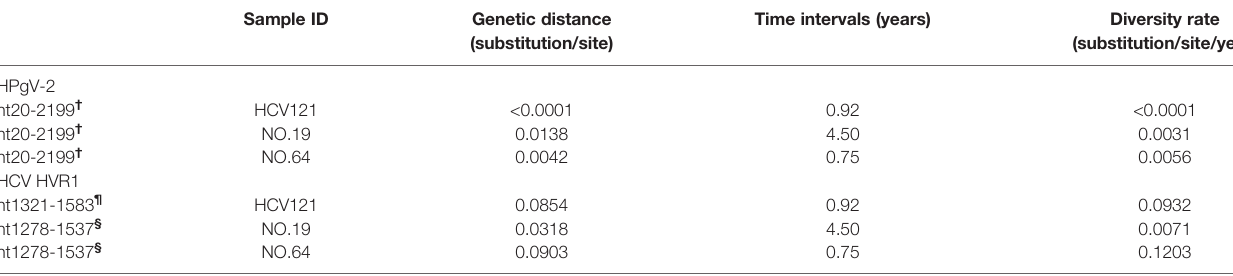
TABLE 2 | Diversity rate of HPgV-2 and HCV from HCV/HPgV-2-coinfected patients. Sample ID Genetic distance Time intervals (years) Diversity rate (substitution/site)